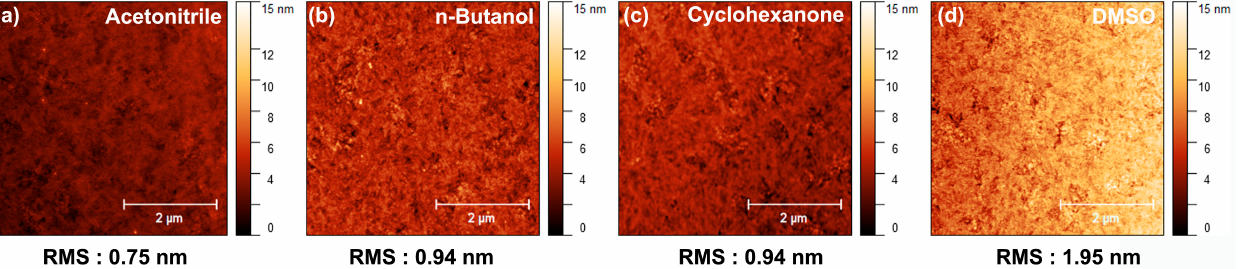
Figure 3. AFM images of PMA thin films with various solvents. Table 1. Boiling point, viscosity, and surface tension of the solvents used.